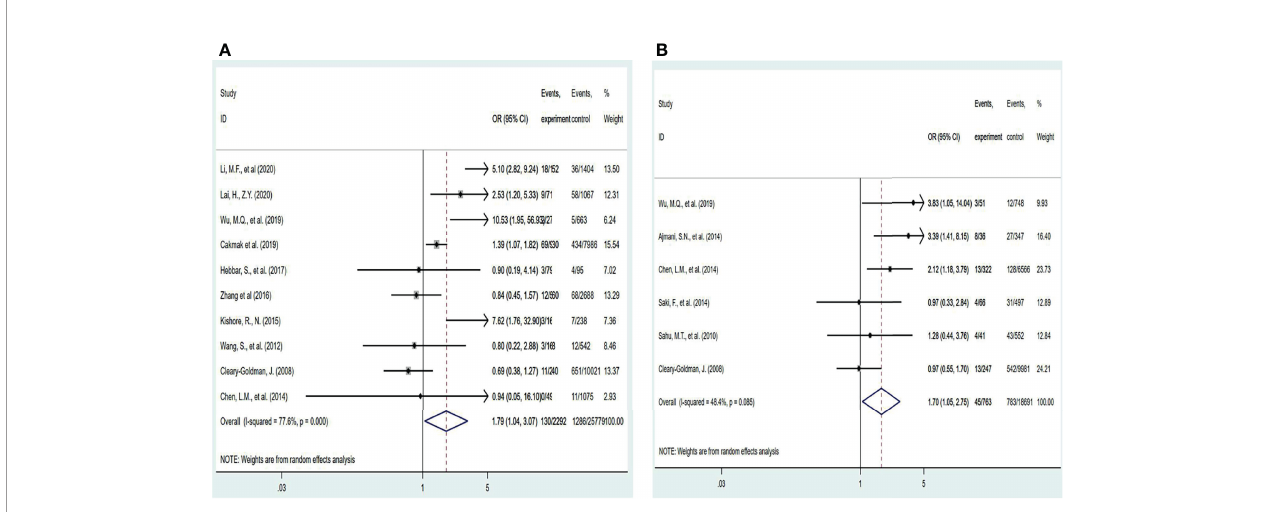
FIGURE 5 | Forest plot of relative risk and 95% CI of pooled studies comparing pregnant women with subclinical hypothyroidism to euthyroid pregnant women for risk of HDP (A) gestational age at a screening at the fi rst trimester and (B) gestational age at a screening at second and third